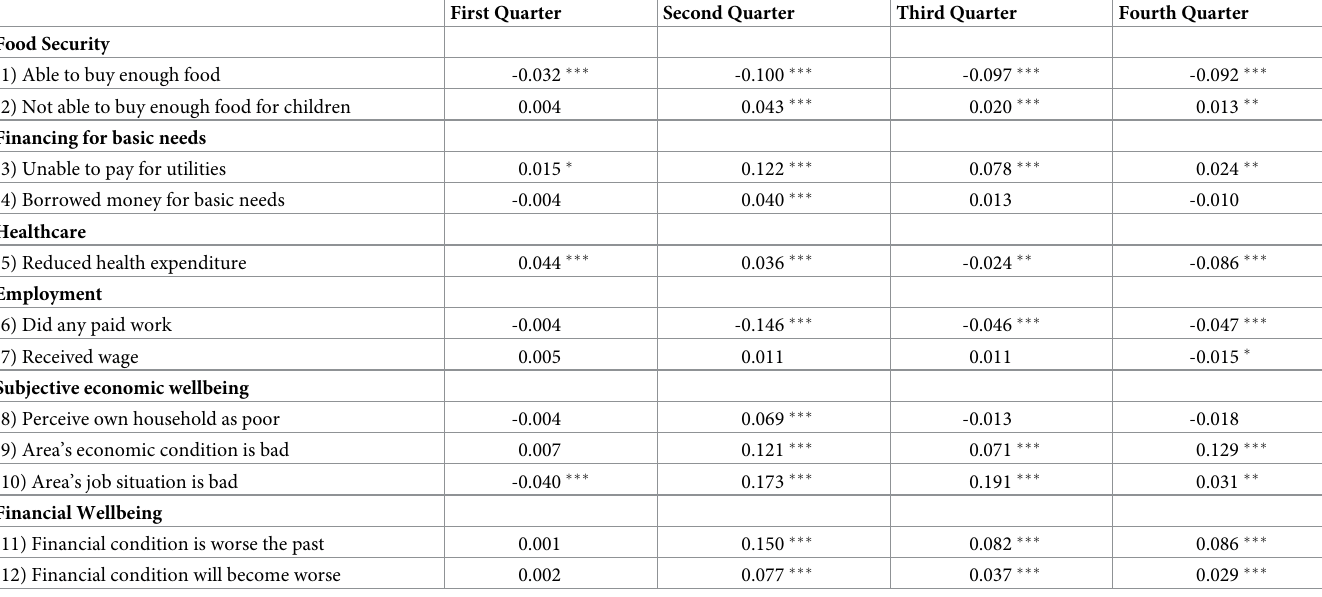
Table 2. Comparison of household welfare before and after the COVID-19